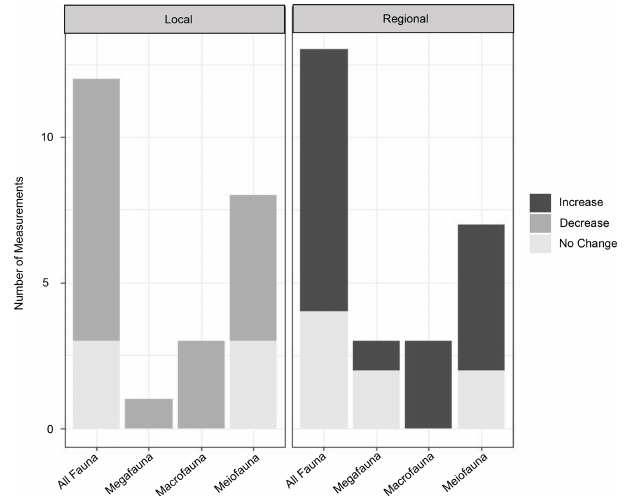
Figure 5. Graphs of the impact of turbidity flows on diversity in three size classes (mega-, macro-, and meiofauna). For local di- versity, the increase, decrease, or no change in species richness or other diversity indices was assessed from individual measurements of these metrics made in the studies listed in Table 1. For regional diversity, the assessment was made based on “unique community” as noted by the authors of these studies, or our interpretation of “uniqueness” from the presented community data (e.g. nMDS plots or